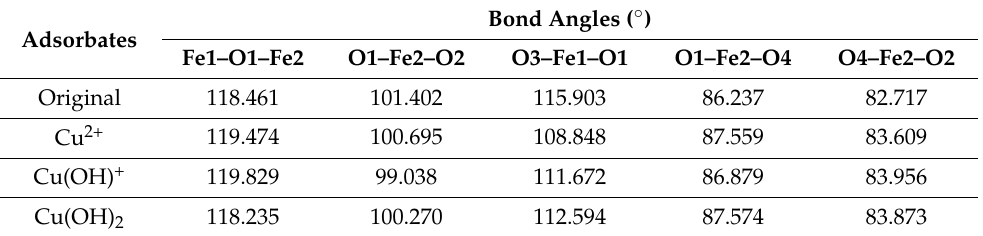
Table 2. Neighboring bond angles before and after Cu species adsorption on specularite (0 0 1)